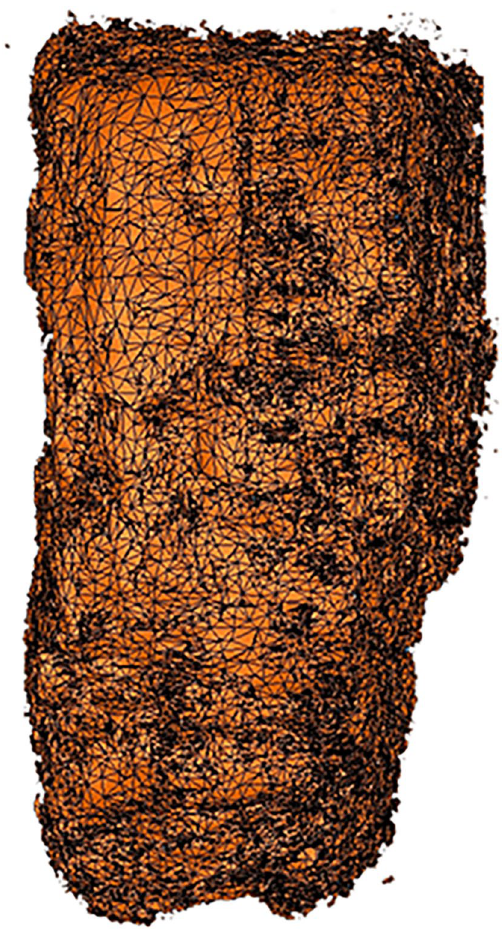
Figure 4. The triangular meshing of PHerc.1103 . The figure shows a simplified representation of the mesh: the triangular density is less than in the real mesh to provide better